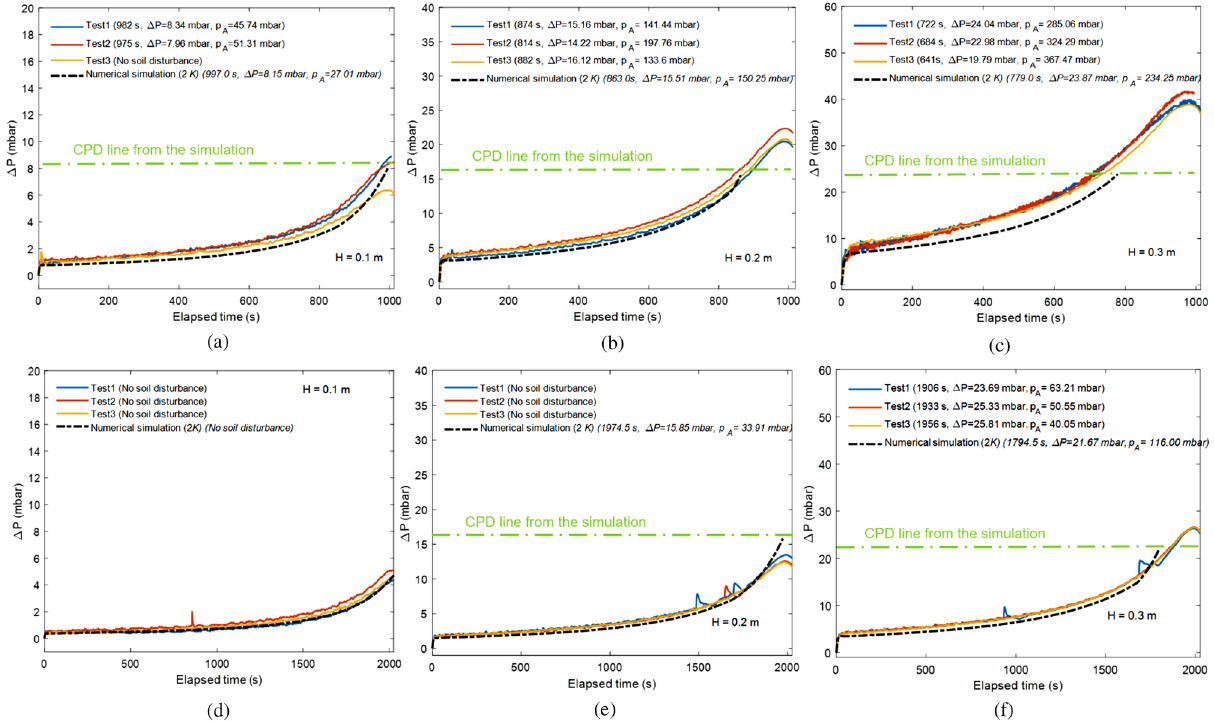
Figure 2. Comparison of experiments and predictions. ( a – c ) Results for a depressurization rate of 1.0 mbar s –1 . ( d – f ) Results for a depressurization rate of 0.5 mbar s –1 . H : height of the simulant bed in both experiments and numerical simulations. CPD : Critical Pressure Difference; ΔP is calculated as the difference between the pressure measurements at the top and bottom of the simulant